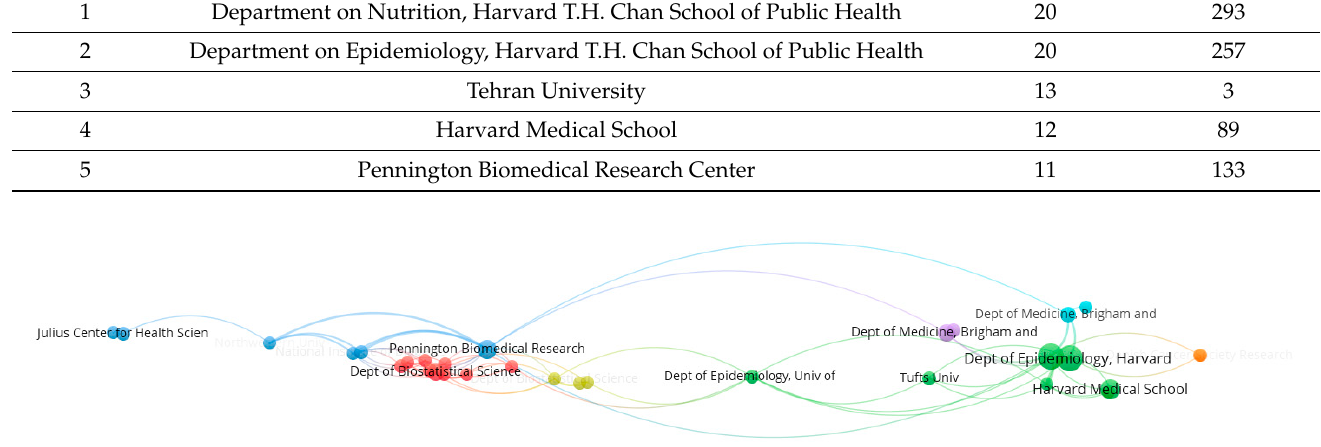
Figure 2. Distribution and co-authorship of organizations.